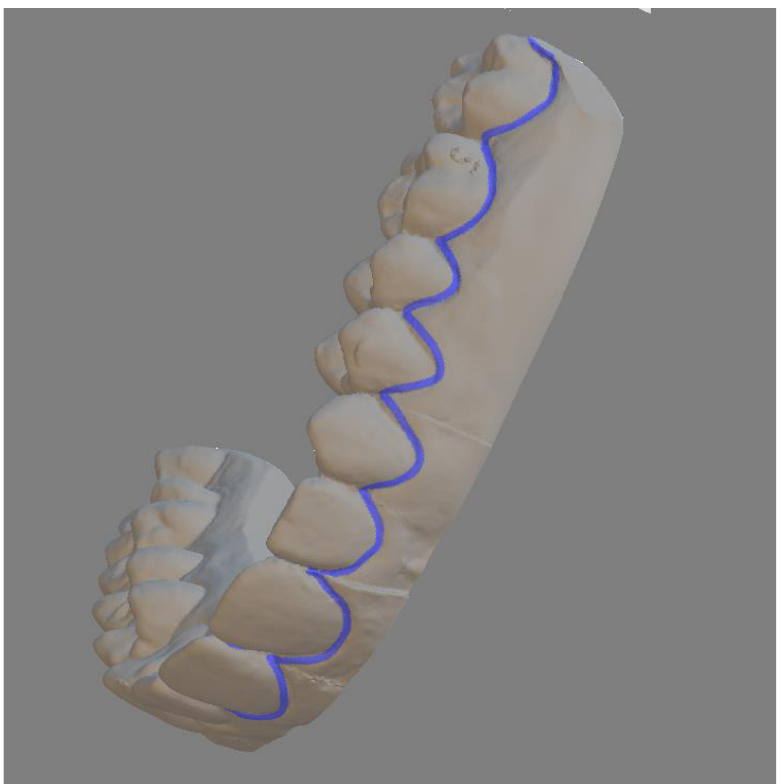
Figure 2. Representative scheme of the removed area (soft tissue) and the area of interest for measurement (teeth).